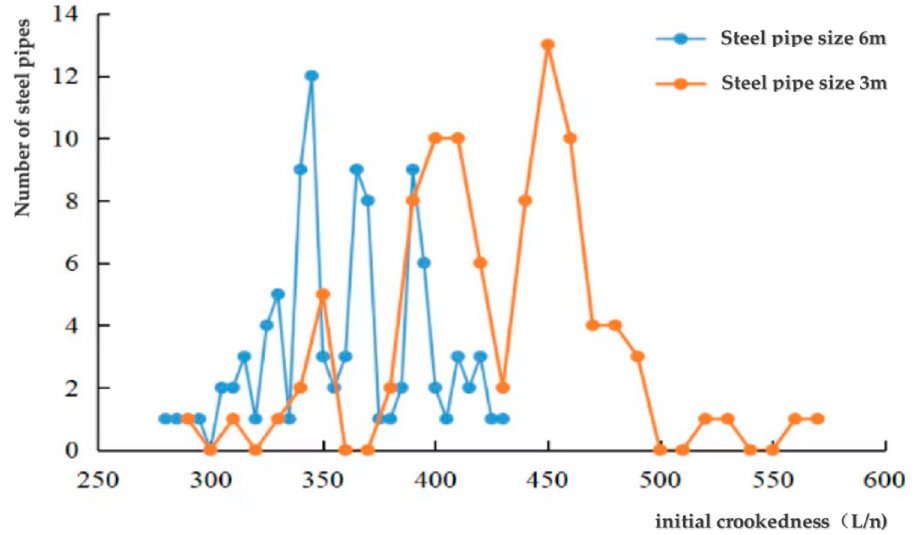
Figure 1. Distribution of initial